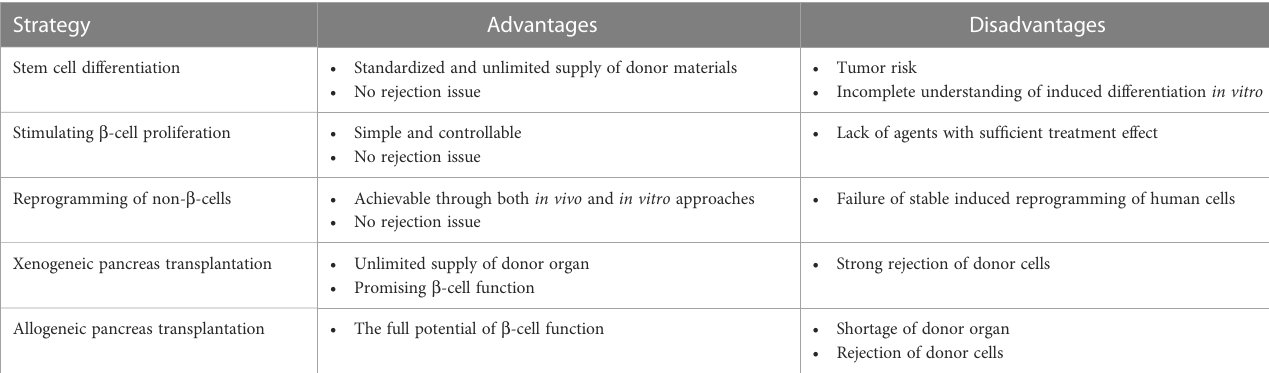
TABLE 1 Possible b -cell centered strategies that can supplement T2DM treatment for disease relapse after bariatric surgeries.